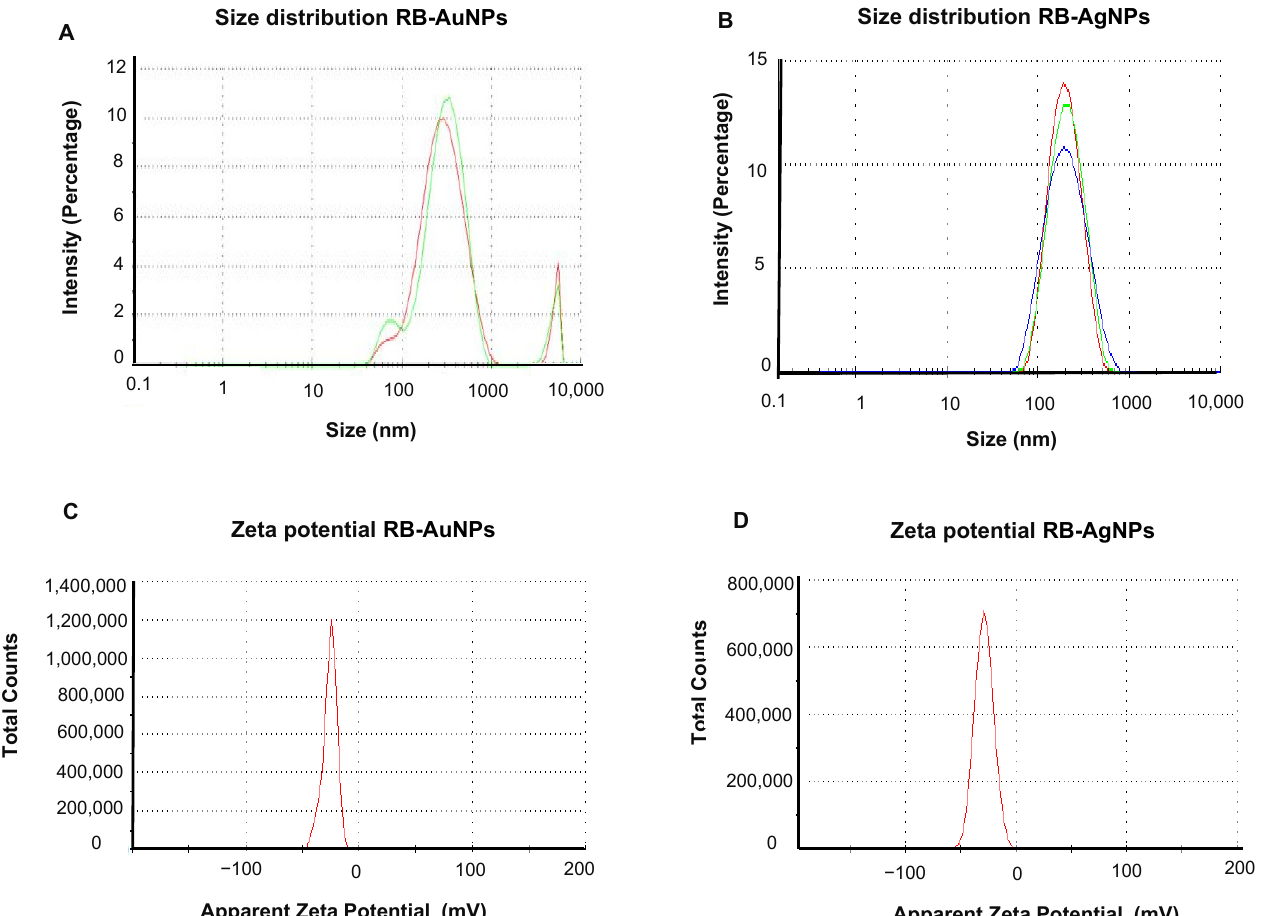
Figure 4. Dynamic light scattering analysis of RB-AuNPs and RB-AgNPs. ( A ) RB-AuNPs distribution concerning size and intensity ( B ) RB-AgNPs distribution concerning size and intensity. Different color represents technical replicates. ( C ) Zeta potential of RB-AuNPs and ( D ) RB-AgNPs, representing highly negative surface